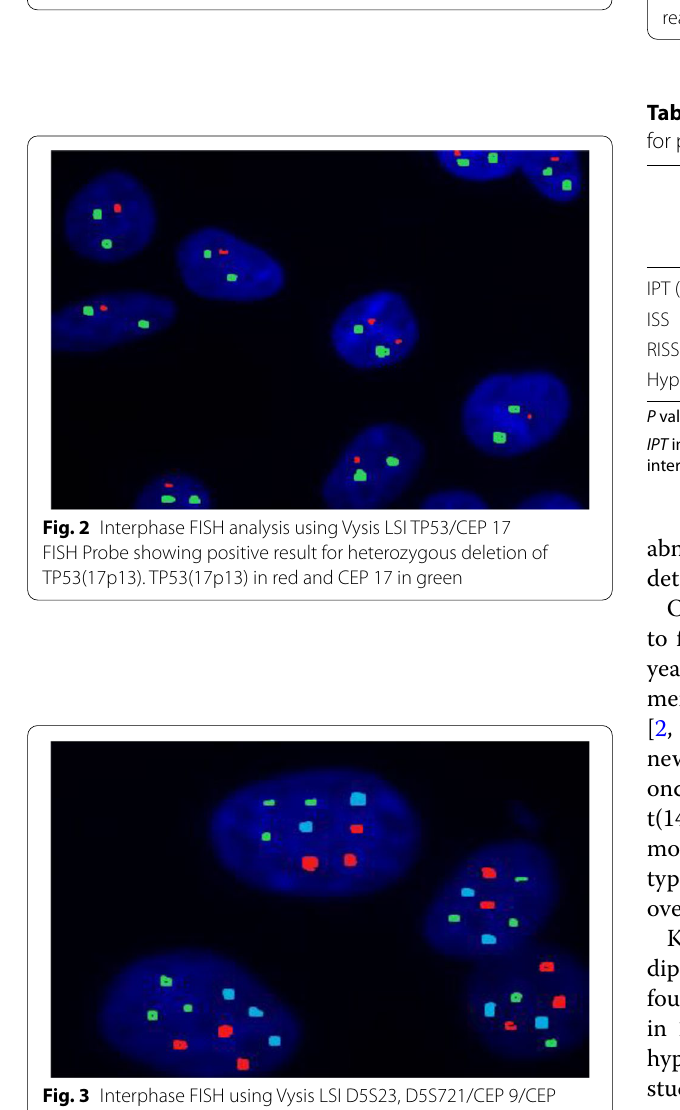
Fig. 1 Interphase FISH analysis using LSI IGH/FGFR3 DF probe showing t(4 ′ 14)(p16;q32)(FGFR3/IGH). IGH in green and FGFR3 in red